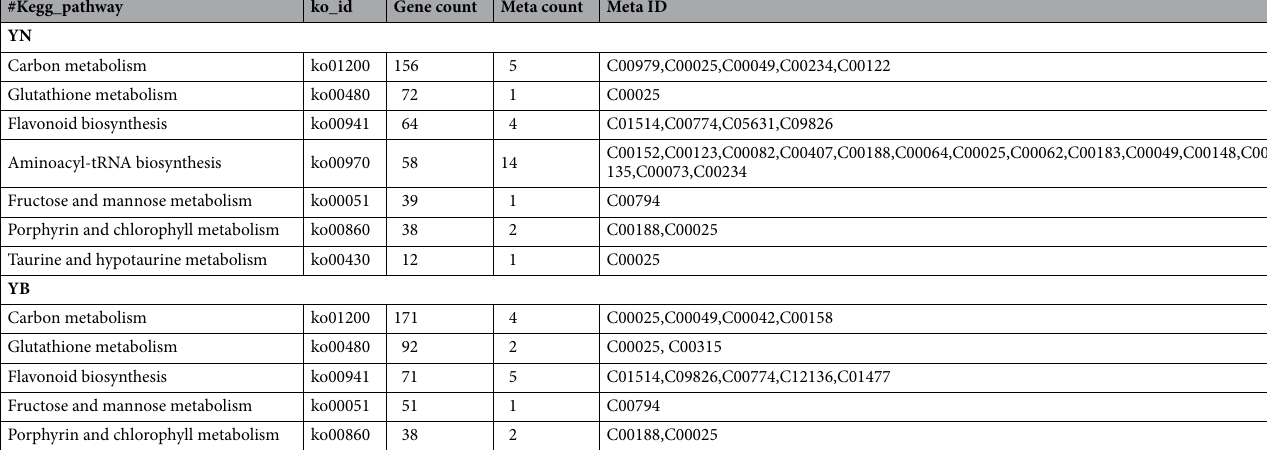
Table 1. Integrated analysis of differentially expressed genes and differentially accumulated metabolites associated with KEGG pathways.